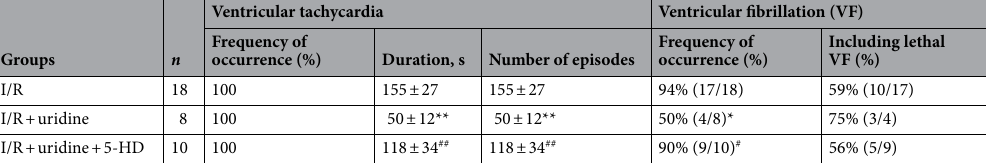
Table 4. Effect of uridine on the ventricular tachycardia and ventricular fibrillation associated with myocardial I/R damage. I/R ischemia/reperfusion, 5-HD 5-hydroxydecanoate. All data are the mean ± SD ( n = 8–18). *p < 0.05 versus I/R group, **p < 0.01 versus I/R group; # p < 0.05 versus I/R + uridine group, ## p < 0.01 versus I/R + uridine group. Significance of differences was determined by a one-way ANOVA followed by the Turkey’s multiple comparison Post Hoc